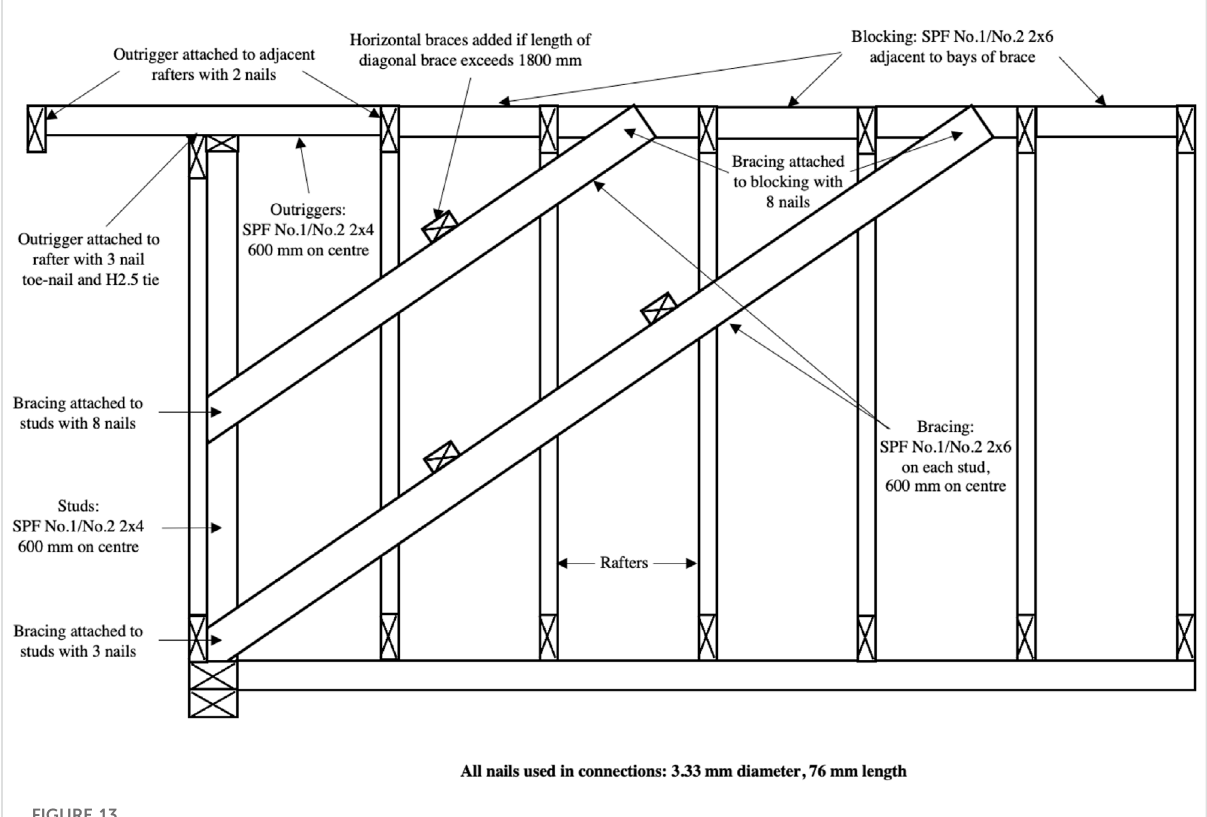
FIGURE 13 The recommended connections and members in the outrigger framing and bracing (after CSA